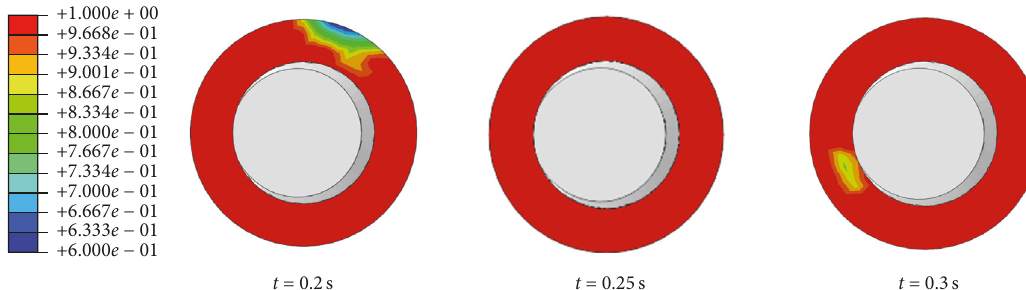
Figure 22: The slip state contours at different time.